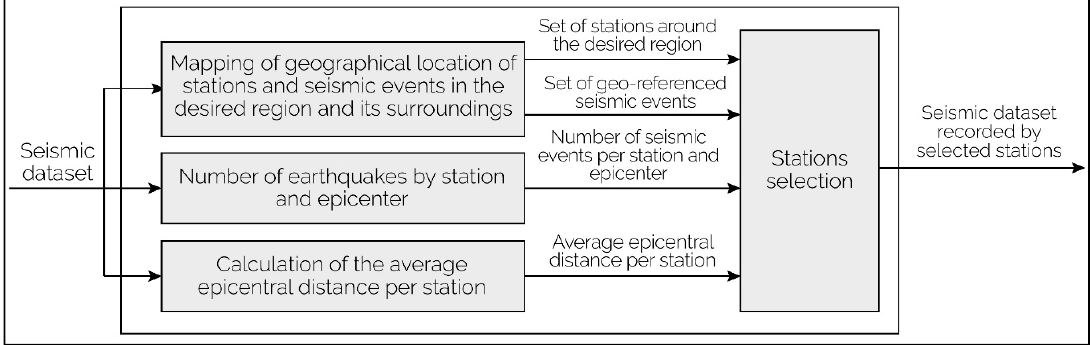
Figure 4. Seismological station selection process.